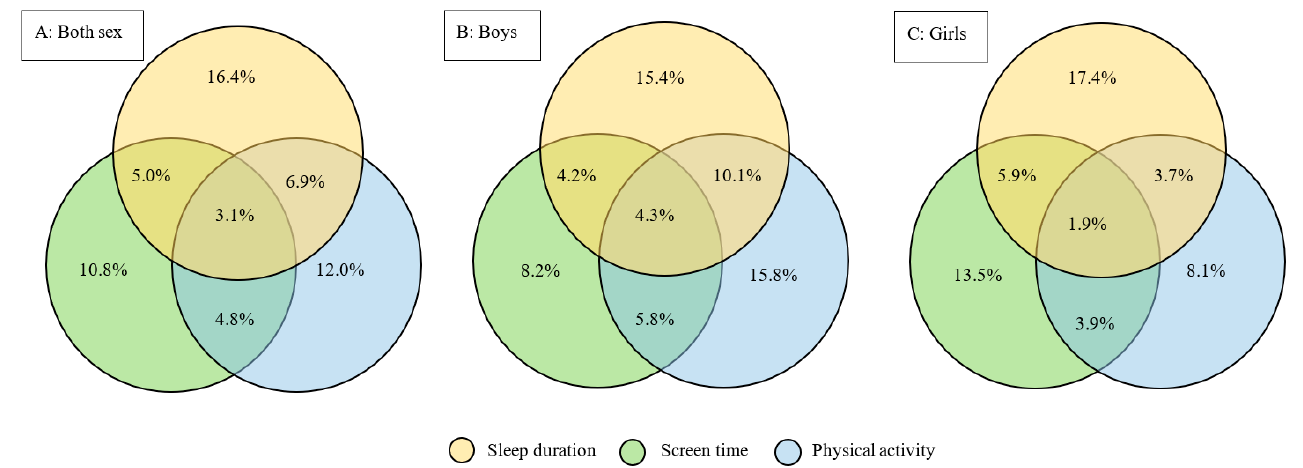
Figure 1. Venn diagrams showing the weighted prevalence of meeting all and part recommendations of the 24 h movement guidelines in total and by sex among the adolescents of the U.S.